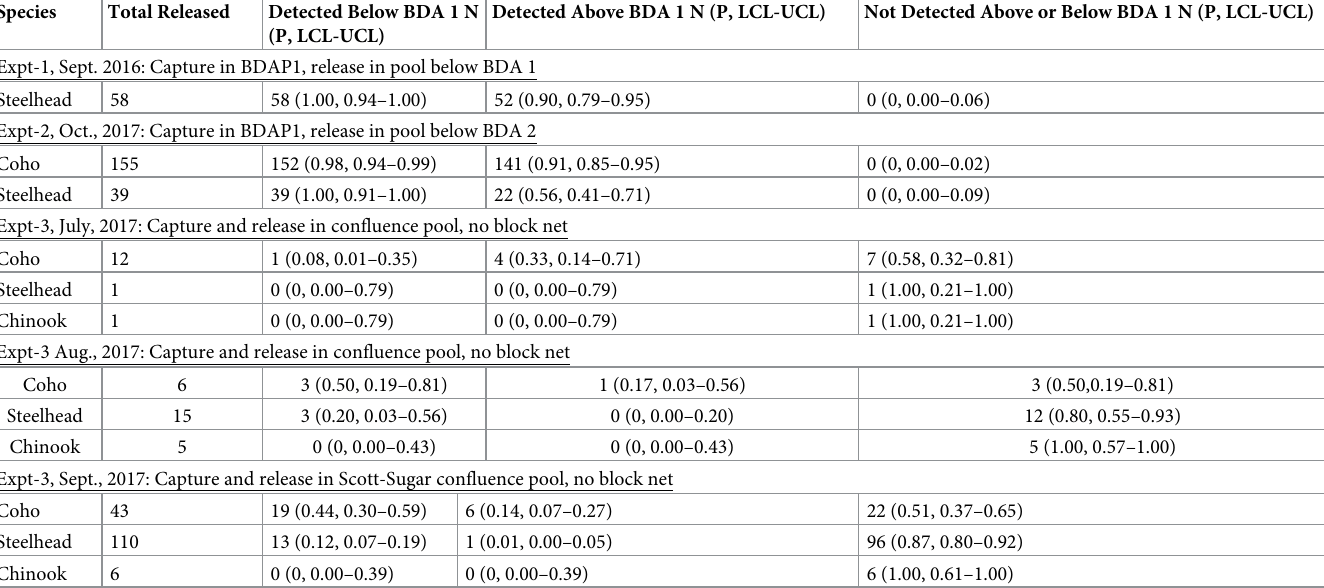
Table 2. Summary of 3 experimental releases of tagged juvenile steelhead trout and coho and Chinook salmon below beaver dam analogues in 2016 and 2017.